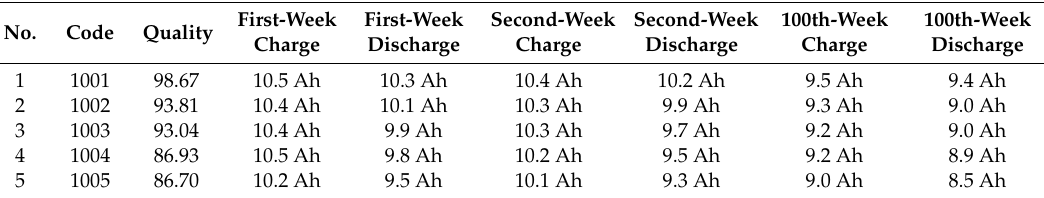
Table 8. Product quality evaluation table.